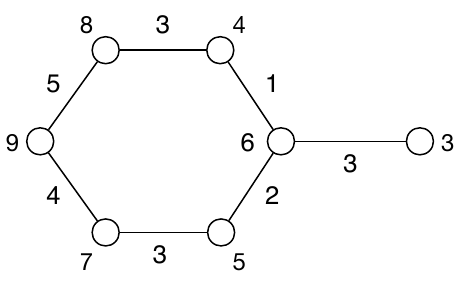
Figure 5: IAM( T (6 , 1)) = { 7 , 8 , 9 , . . . } .